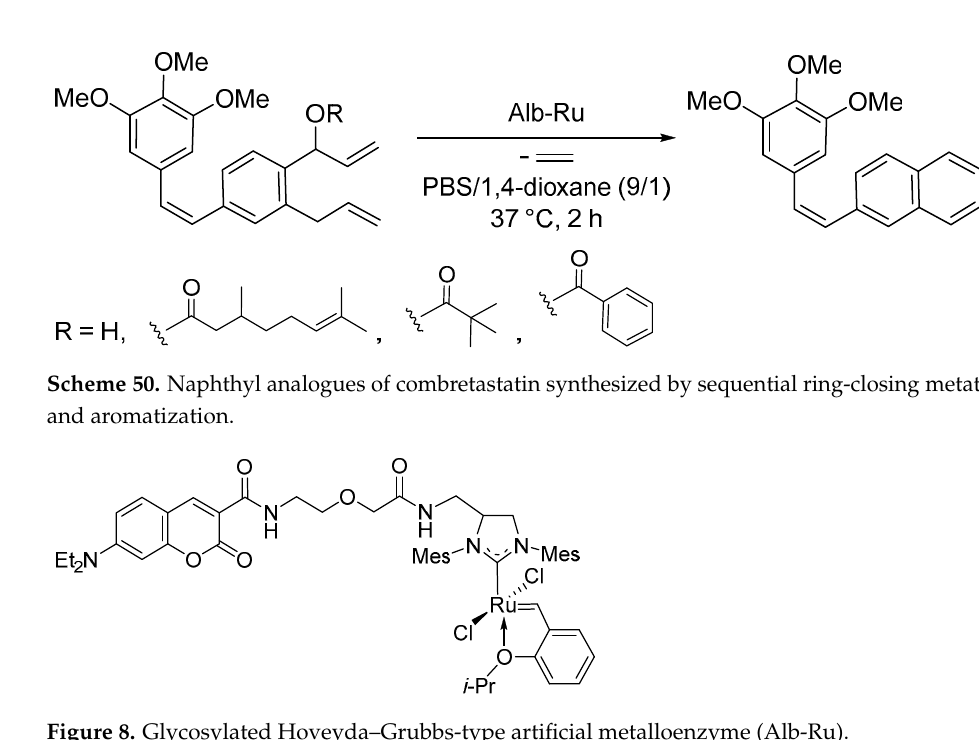
Figure 7. The scope of synthesized binaphthyl atropisomers.